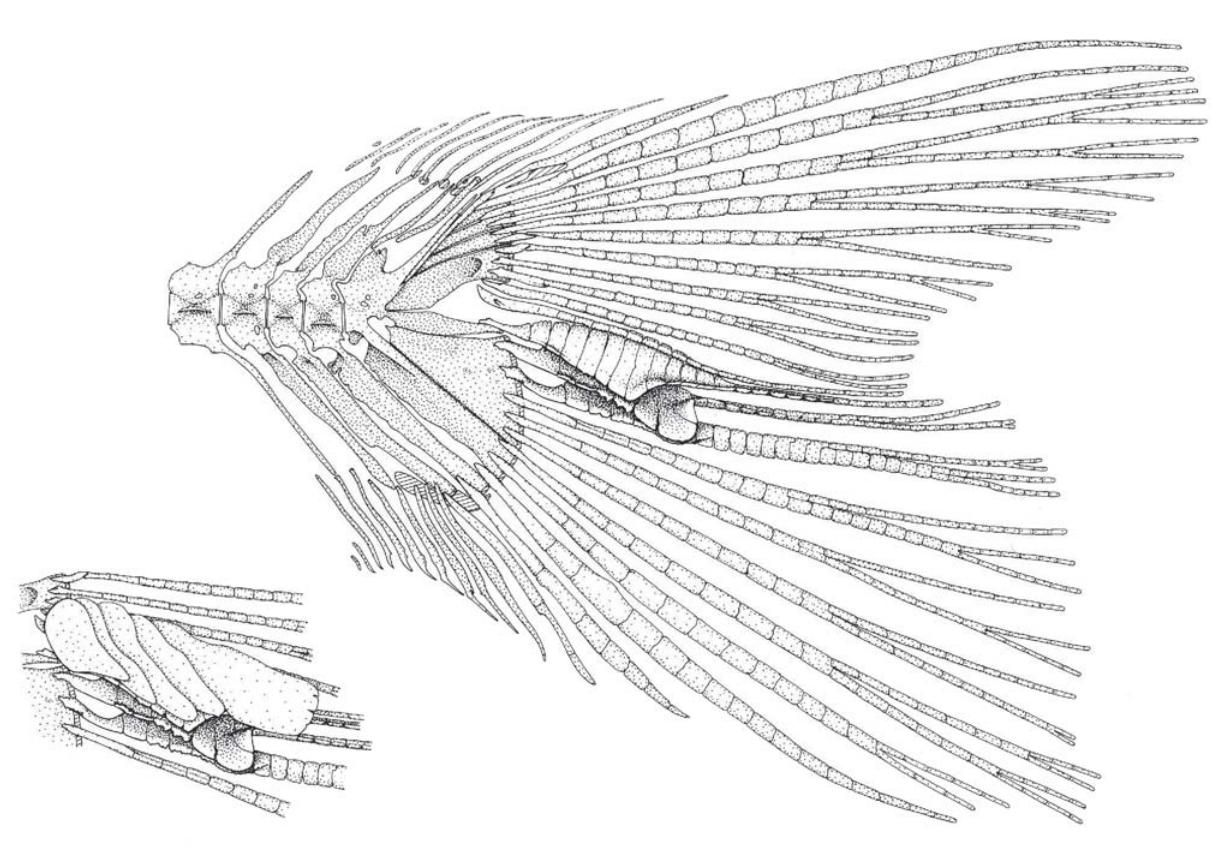
Fig. 58. Mimagoniates lateralis , adult male, USNM 236088, 31.6 mm SL; caudal skeleton, lateral view, left side, anterior at left. Inset at lower left illustrates modified dorsal lobe caudal-fin squamation in relation to osteological structures of caudal organ. Modified from Weitzman et al . (1988).